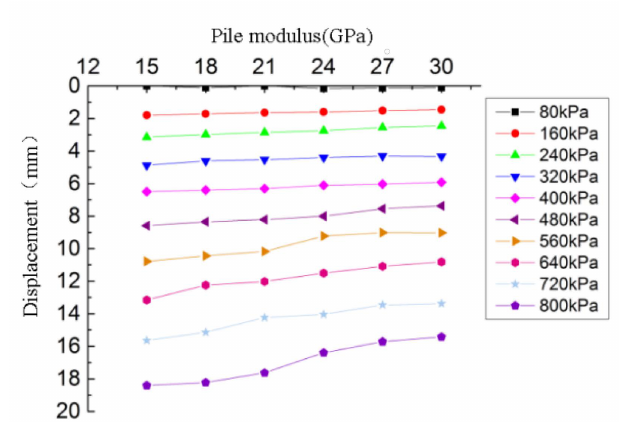
Figure 24. The elastic modulus of the pile e ff ect on the curve of settlement. Energies 2020 , 13 , x FOR PEER REVIEW